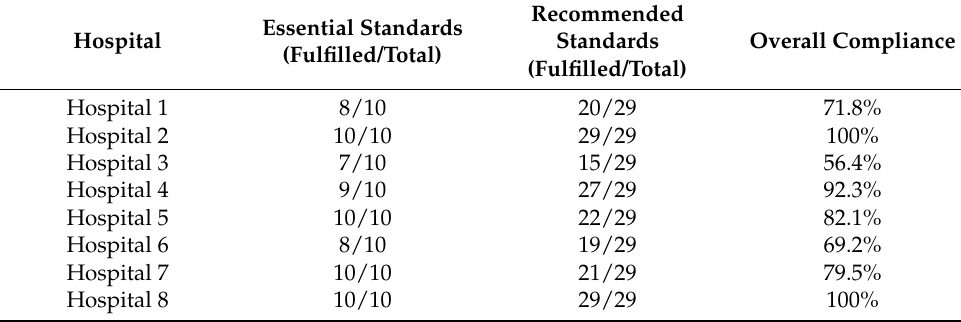
Table 2. Results of the self-evaluation